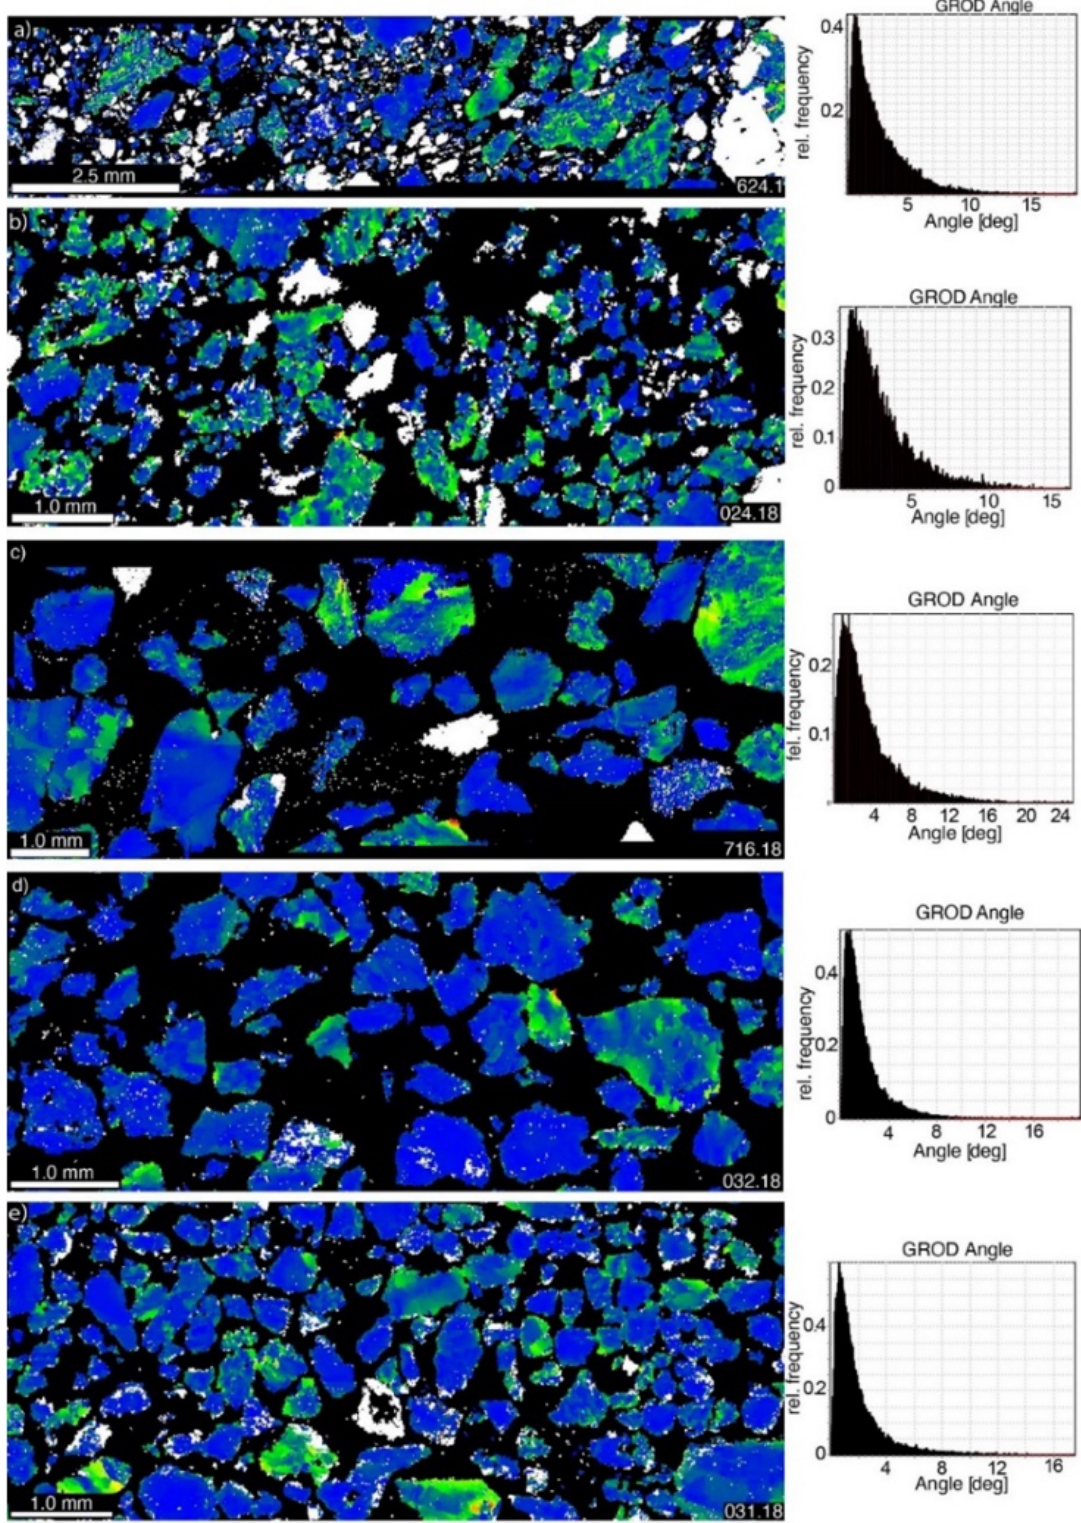
Figure 5. GROD angle map highlighting areas of deformation and the GROD angle histograms for each sample. Note: the less deformed grains are shown in blue and the most deformed ones in yellow to green. Minerals other than quartz are in